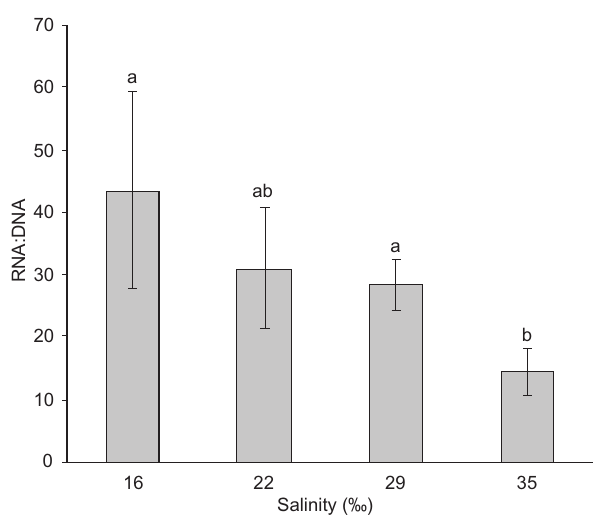
Figure 2. RNA:DNA ratios of F. paulensis postlarvae (PL climation from a salinity of 30‰ to different test salinities (16, 22, 29, and 35‰) at 24.7 ± 1.6°C and 388 ind/m 2 . Vertical bars indi- cate standard deviations. Different superscript letters denote sig- nificant differences (p < 0.05).